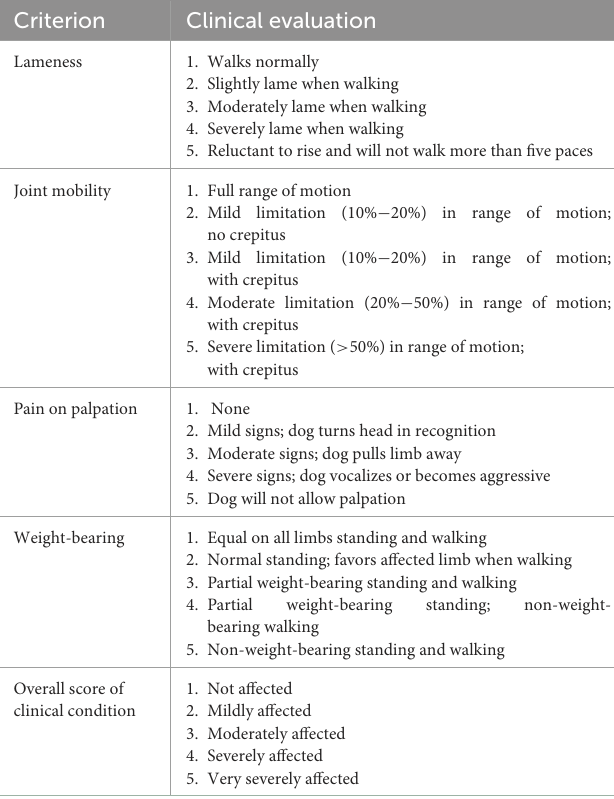
TABLE 1 Assessment system used in the orthopedic evaluation (Orthopedic Assessment Scores, OAS). Criterion